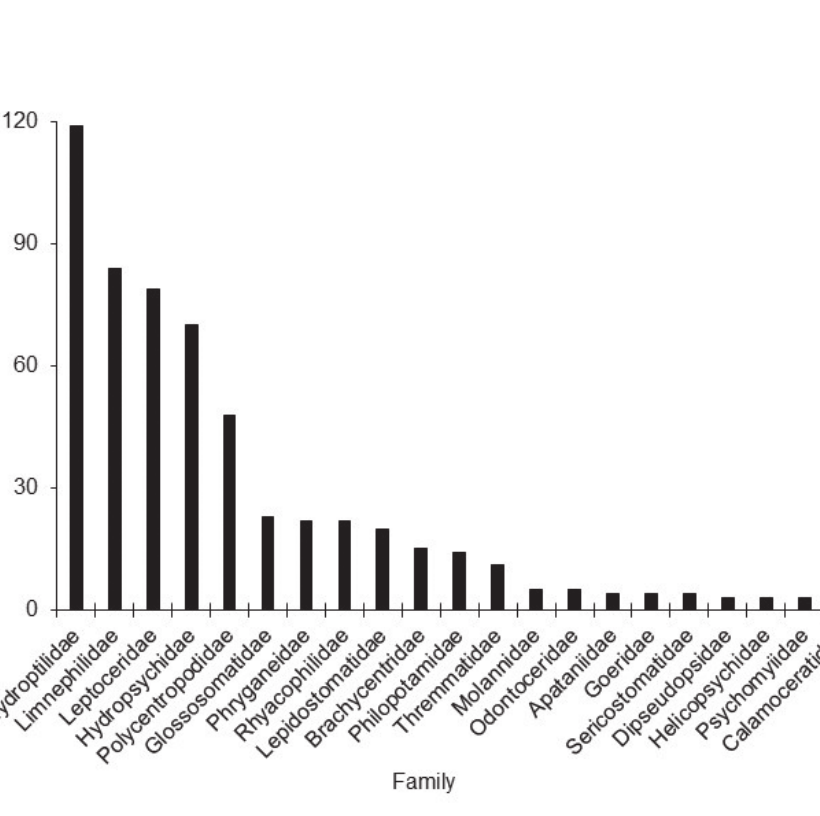
Figure 3. The total number of caddisfly species within each family known from the Upper Midwest region. N = 552 total